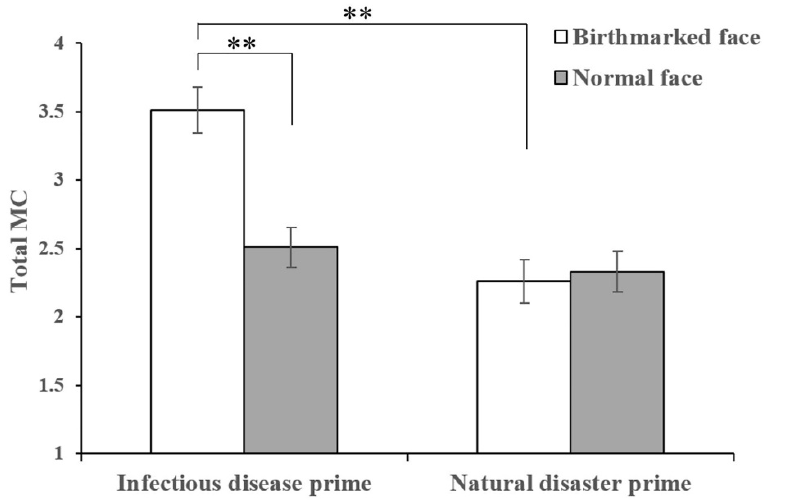
Figure 3. The influence of the interaction between threat prime and disease-connoting cue on total MC (displayed ± SE ). ** p < 0.01.